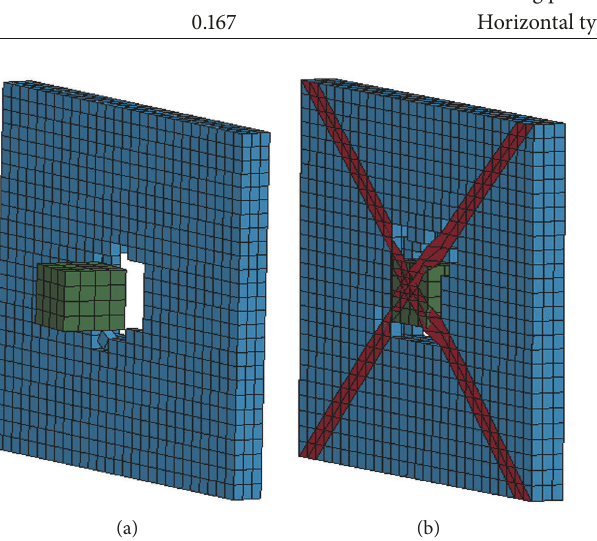
Figure 5: The condition of the two models at 𝑇 = 15ms: (a) control model and (b) reinforced model.